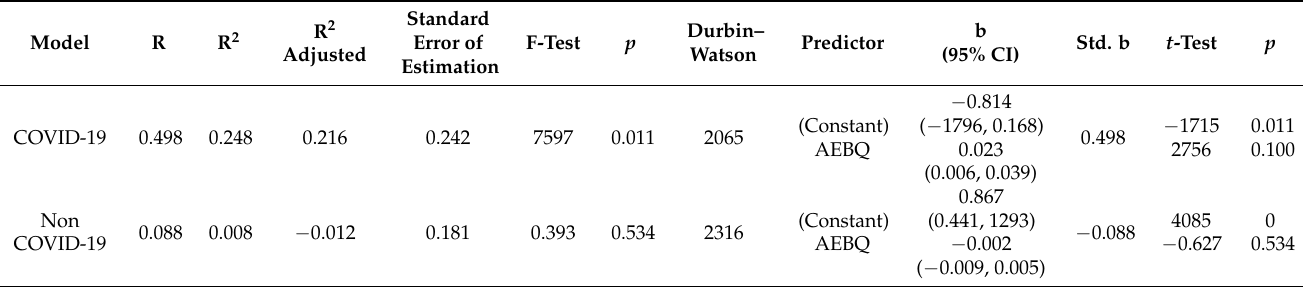
Table 3. Correlations between AEBQ and EuroQoL scores during lockdown.